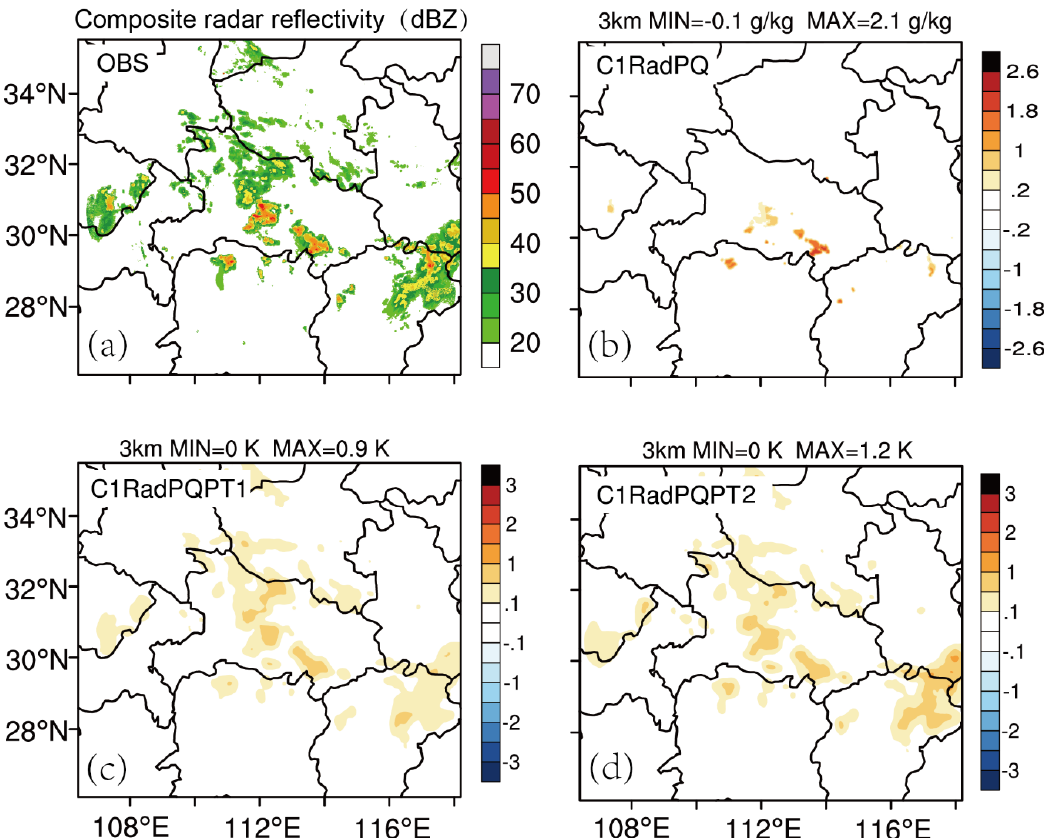
Figure 4. The observed composite radar reflectivity (dBZ) field( a ), analysis increments of qv for C1RadPQ ( b ), analysis increments of θ for C1RadPQPT1 ( c ), and analysis increments of θ for C1RadPQPT2 ( d ) at 3 km AGL , 0000 UTC, 30 June 2018.